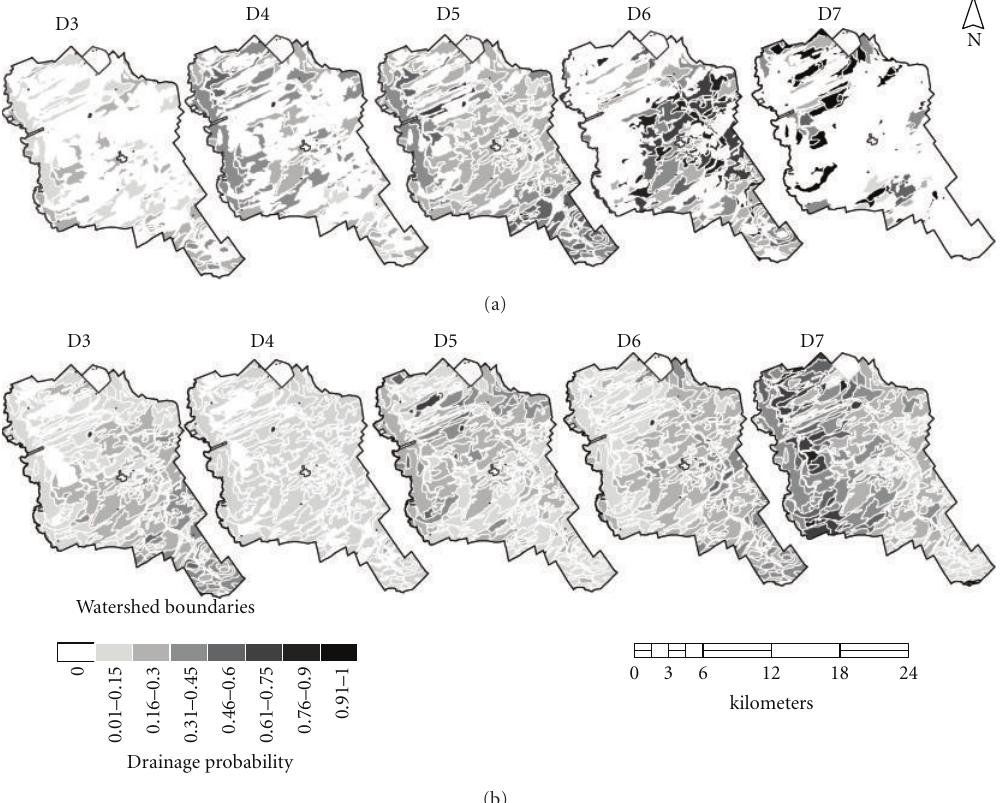
Figure 9: Maps showing the probability of occurrence of each soil drainage class (D3–D7) within each soil polygon (expressed in % of the polygon area) as estimated from (a) the conventional soil map and (b) the decision tree